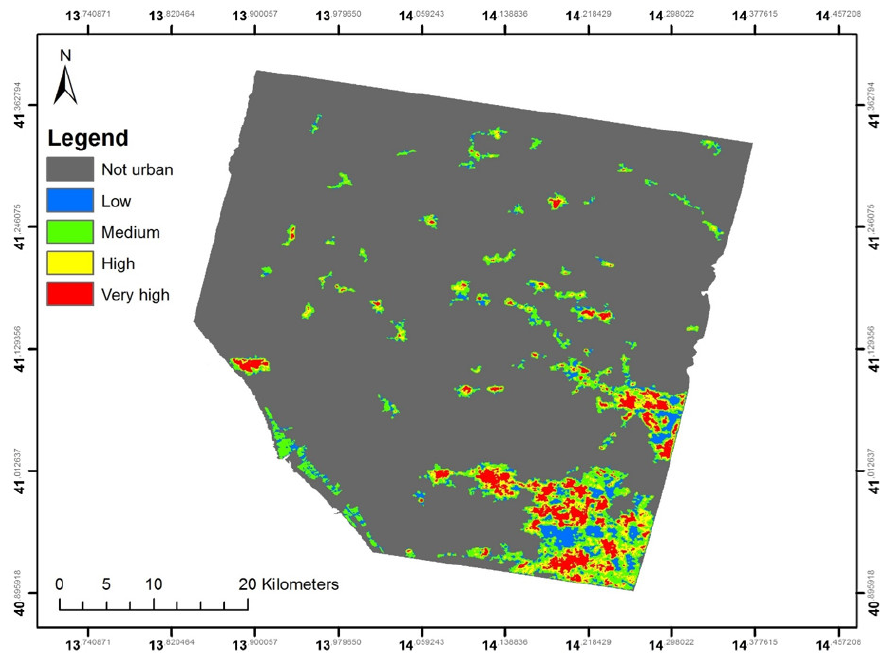
Figure 6. Urban density map for the Napoli area extracted by applying the proposed methodology to the input Level-1α product depicted in Figure 2a. Minimum mapped area: 300,000 m 2 . Urban density windows ~150 m and ~450 m.